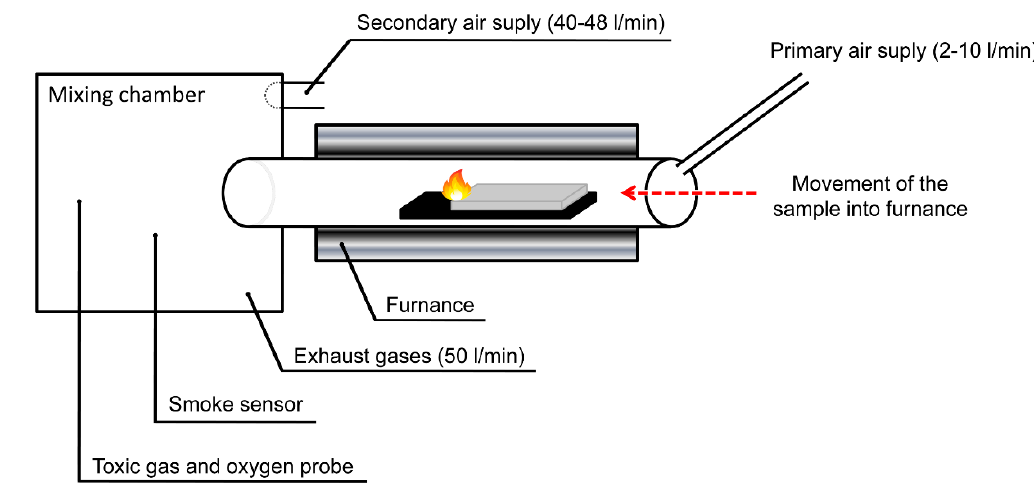
Figure 1. The scheme of steady state tube furnace (Purser furnace), adapted from [18].